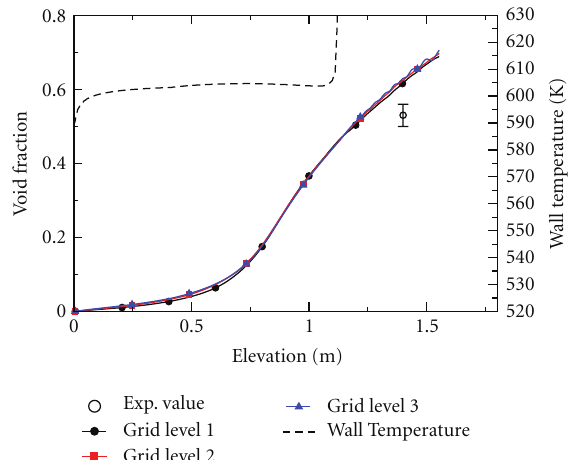
Figure 9: Run 1.4326. Axial evolution of the cross-section averaged void fraction for the 3 grid levels.